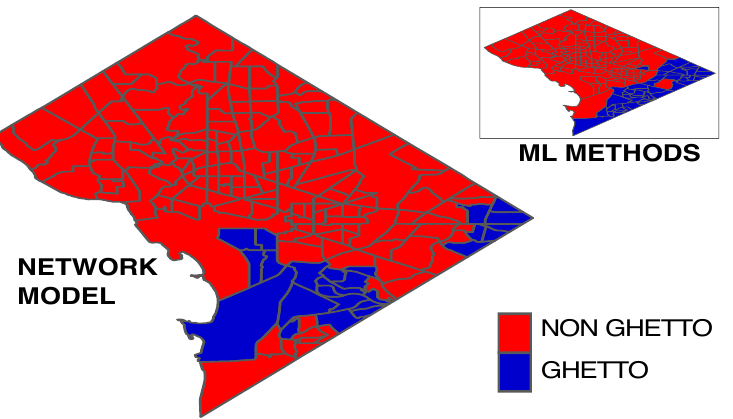
Figure 6. Mapping from the network model snapshot (Figure 4b) to the real city. In order to compare these results with the ones from ML, illustrated in Figure 5c, the inset exhibit the same zone